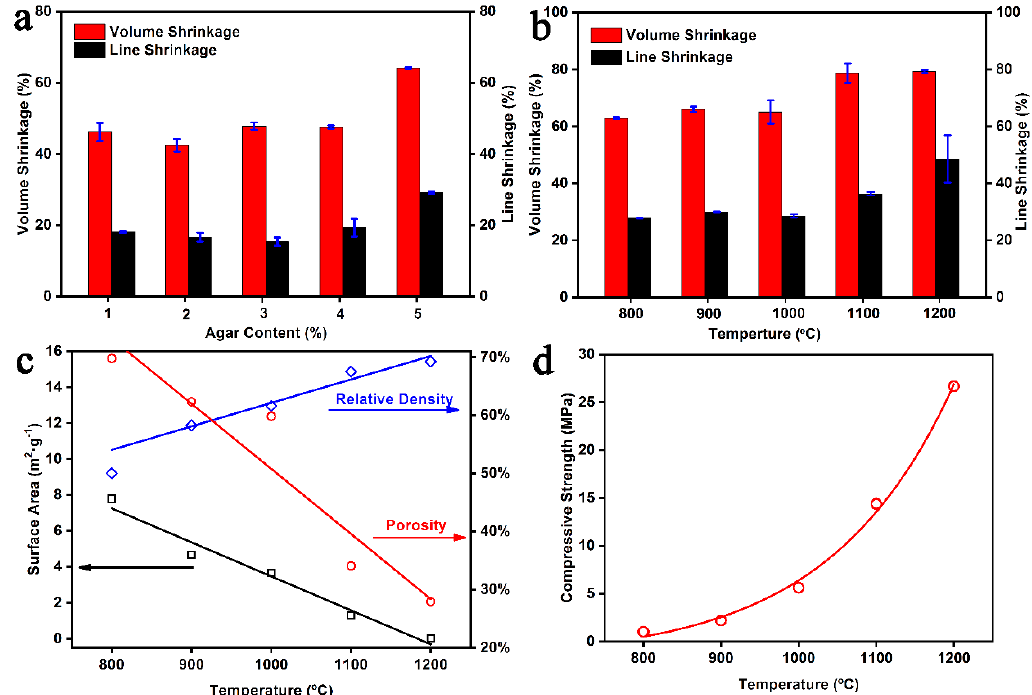
Figure 4. ( a ) The effect of agar concentration on the linear and volume shrinkage during dehydration; ( b ) the effect of sintering temperature on the linear and volume shrinkage during high-temperature sintering treatment; ( c ) the effect of sintering temperature on the specific surface area, porosity, and relative density of LSM sintered bodies; ( d ) the effect of sintering temperature on the compressive strength of LSM sintered bodies (the compression speed was 2 mm/min).